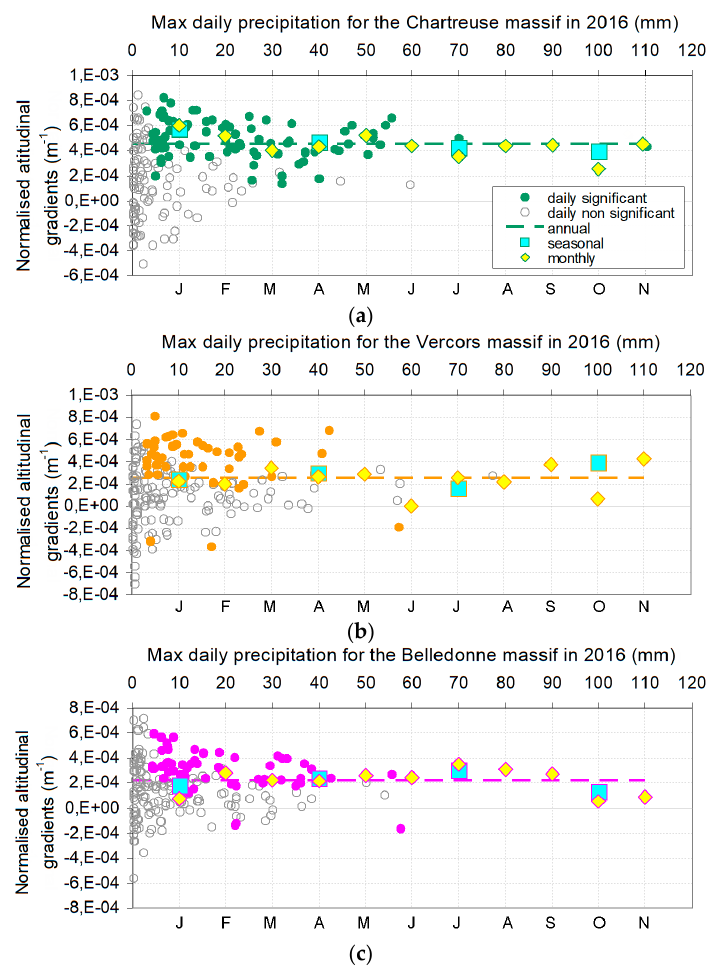
Figure 6. Comparison of the relative altitudinal gradient estimates for Chartreuse ( a ), Vercors ( b ), and Belledonne ( c ). Colored circles: significant daily gradient estimates as a function of the maximal daily precipitation in mm (top scale). Non-colored circles: non-significant daily gradient estimates as a function of the maximal daily precipitation. Dashed line: annual gradient estimate. Square and diamond respectively seasonal and monthly gradient estimates as a function of time (bottom scale). For Belledonne, the subset of nine rain gauges is considered in order to have values in